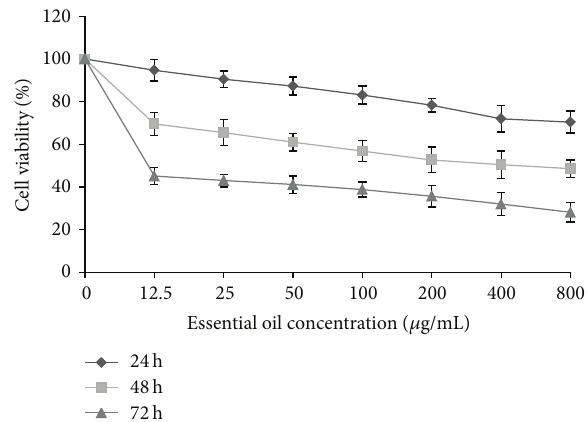
Figure 1: Satureja montana L. essential oil cytotoxicity on A549